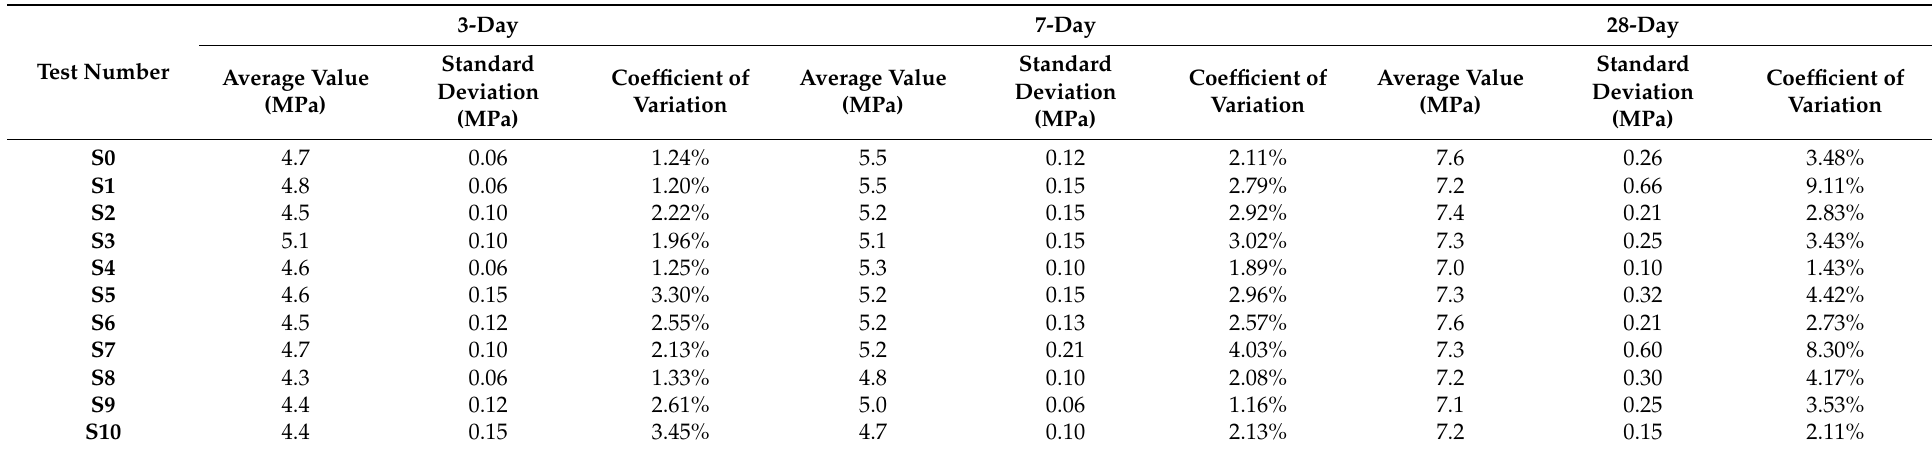
Table 5. Test results of mortar flexural strength of standard sand.